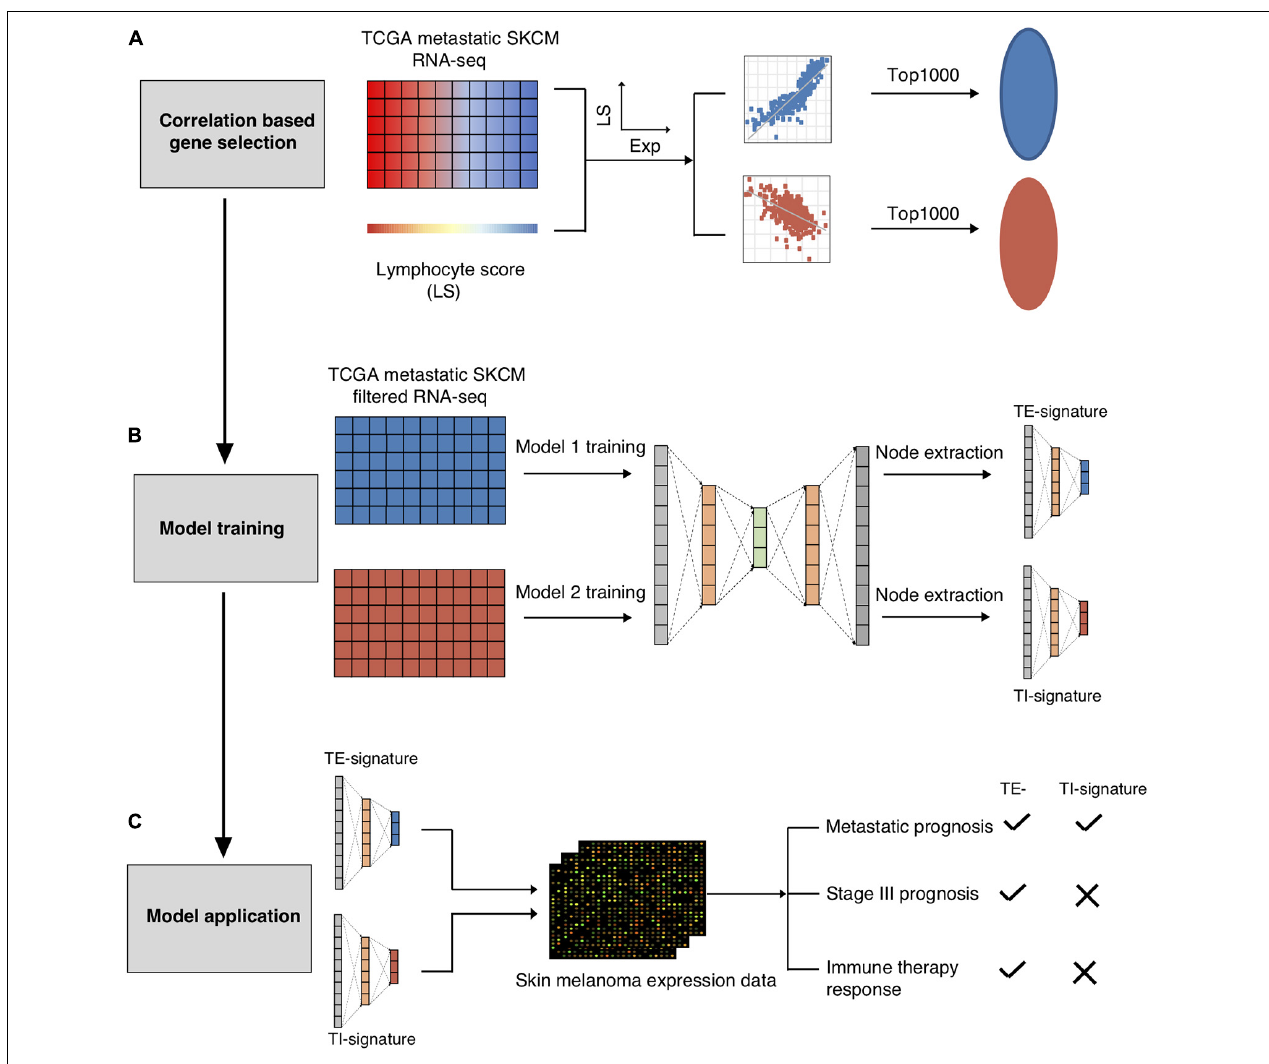
FIGURE 1 | Schematic overview of present study. The TCGA-SKCM metastatic RNA-seq dataset was used to screen out the immune cell and tumor cell related genes. (A) The RNA-seq dataset was further split into immune cell related genes expression dataset and tumor cell related gene expression dataset for AutoEncoder decomposition models training. (B) Node TE-signature and TI-signature were chosen as the representatives of the immune cell and tumor cell gene expression datasets. (C) The trained models were further applied into the independent melanoma gene expression dataset for decomposition. Node TE-signature and TI-signature were then examined for predicting prognosis and immune therapy